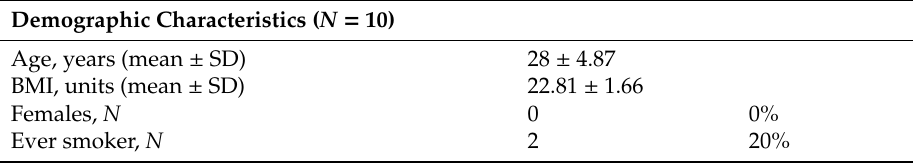
Table 1. Demographic data and current treatment of participating healthy